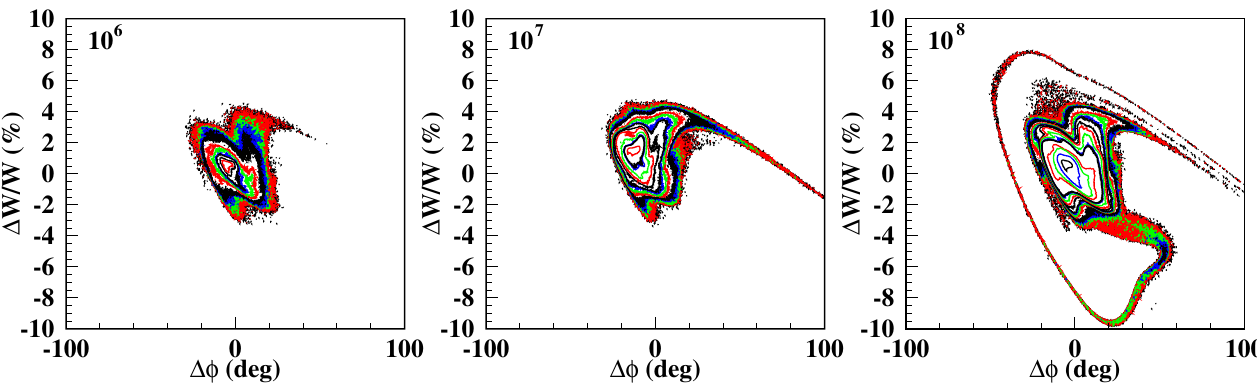
FIG. 16. (Color) Longitudinal phase space plots in the form of ( (cid:3); (cid:1) W=W ) contours. 10 6 particles (left), 10 7 particles (middle), and 10 8 particles